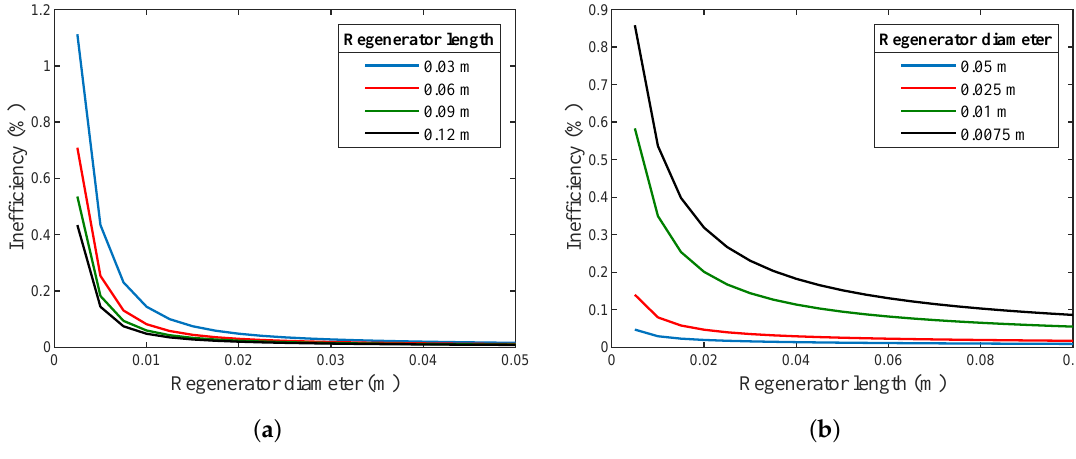
Figure 7. ( a ) The relation between the regenerator diameter and Ie. ( b ) The relation between the regenerator length and Ie (the matrix screen mesh size is 150 × 150 and has a wire diameter of 63 µ